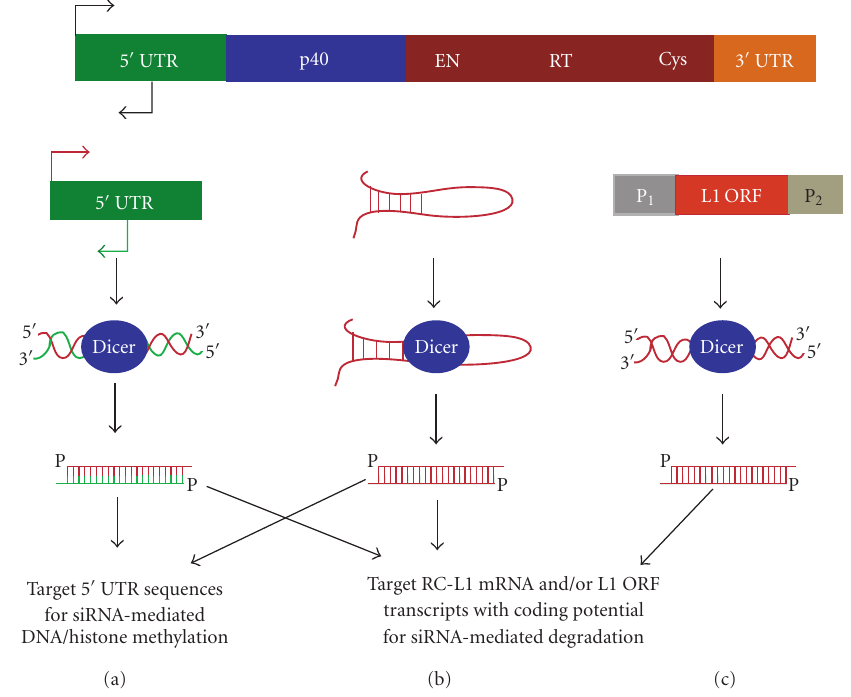
Figure 2: Proposed ways RNAi can control L1 activity. The consensus RC-L1 is depicted above. (a) L1 dsRNA produced from the 5 (cid:2) UTR sense and antisense promoters is processed by Dicer and can target transcripts originating from RC-L1s for degradation. Alternatively, this siRNA can also initiate histone and DNA methylation resulting in silencing of the L1s promoter. (b) Regions of L1 mRNA that form stable hairpins through intramolecular base pairing could be Dicer substrates. The resulting siRNA is capable of a number of responses. (c) L1 dsRNA produced by read-through transcription from opposing cellular promoters is converted into siRNA that can target RC-L1 or ORF transcripts for